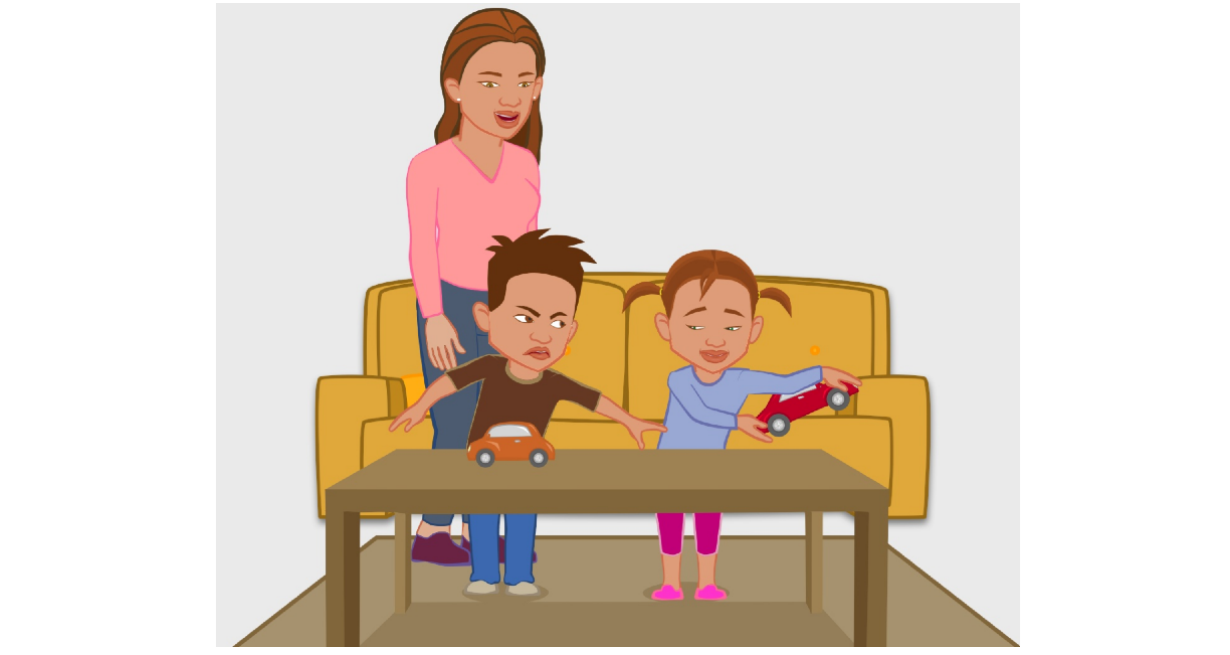
Figure 1. Frame from one of the parenting scenario animations in Play